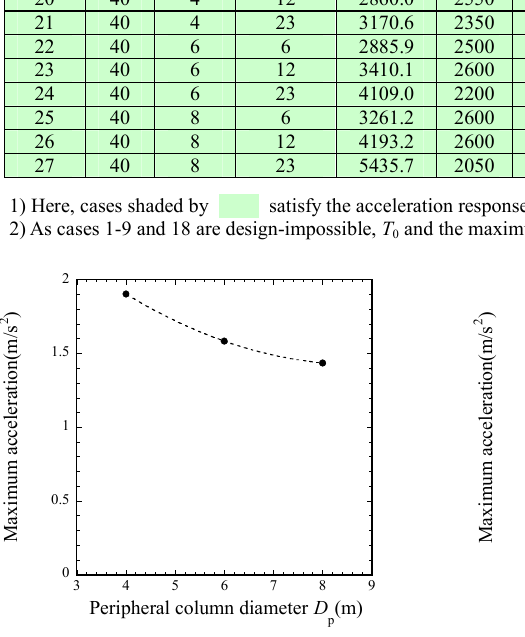
Fig. 12 Hub height maximum acceleration dependency on H p ( L : D p = 30 m: 6 m, T 0 = 2290 kN, under cut-out wind speed conditions, –